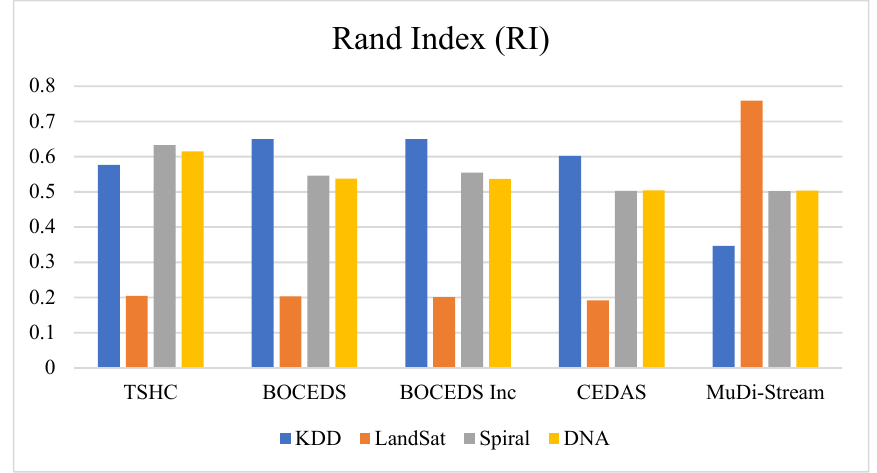
Figure 5. Rand Index Comparison Using KDDCup’99, Landsat, Spiral, and DNA Datasets.